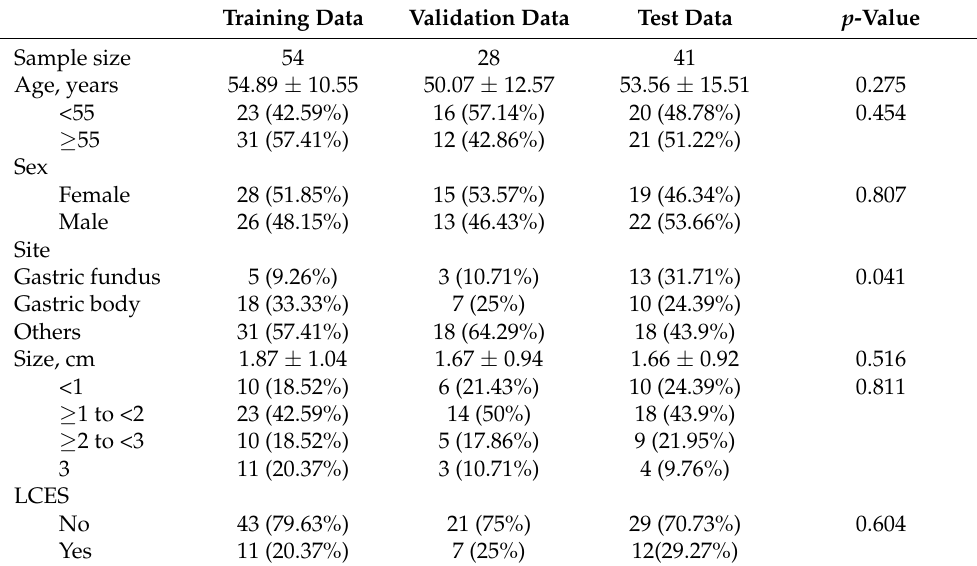
Table 5. Demographics of the training, cross-validation, and test